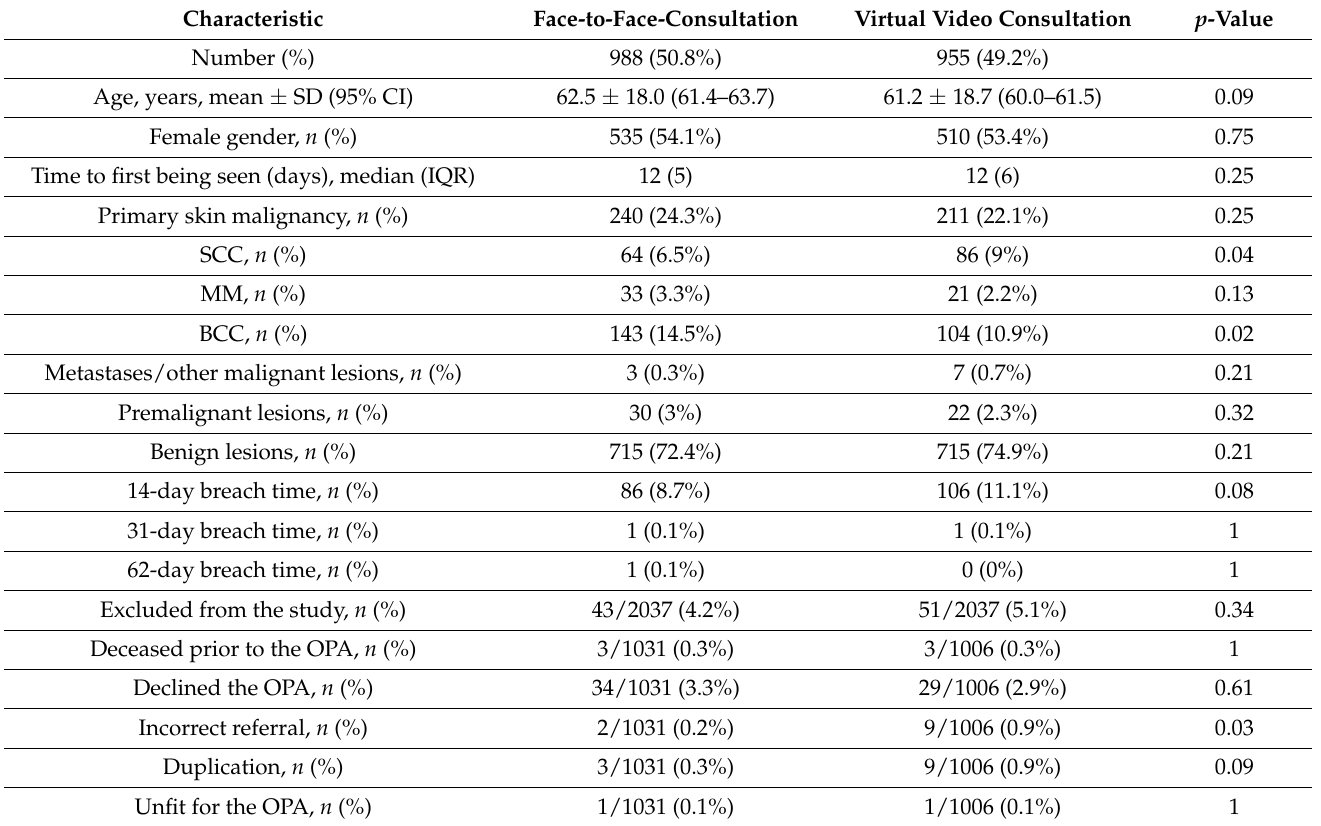
Table 2. Comparison of the two-week wait pathway before and during the pandemic